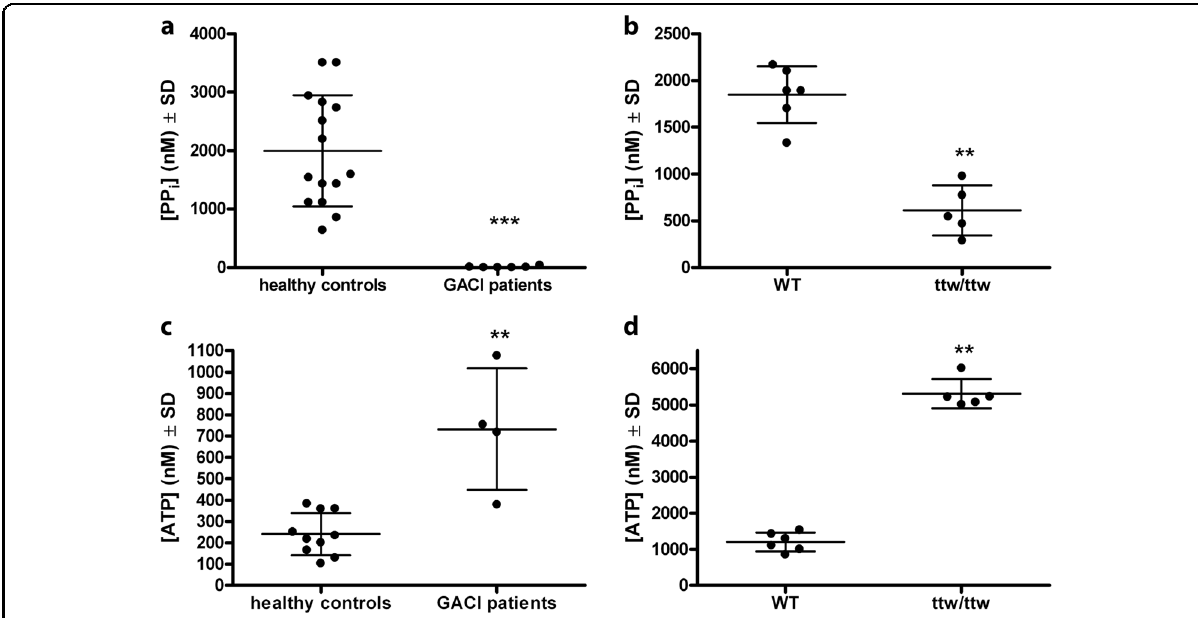
Fig. 1 ENPP1 de fi ciency leads to decreased levels of PP i and elevated levels of ATP in the plasma of GACI individuals and ttw/ttw mice. Plasma levels of PP i ( a , b ) and ATP ( c , d ) were determined from healthy controls ( n = 10) and GACI patients ( n = 4) ( a , c ) and from 7-week-old WT ( n = 6) and ttw/ttw mice ( n = 5) ( b , d ). Plasma levels of ATP from healthy controls ( c ) correspond to normal human EDTA plasma concentrations from previous publications 27 . Values are presented as the mean ± SD. ** p < 0.005, *** p < 0.001 (Student ’ s t test, unpaired two-sample testing for means)